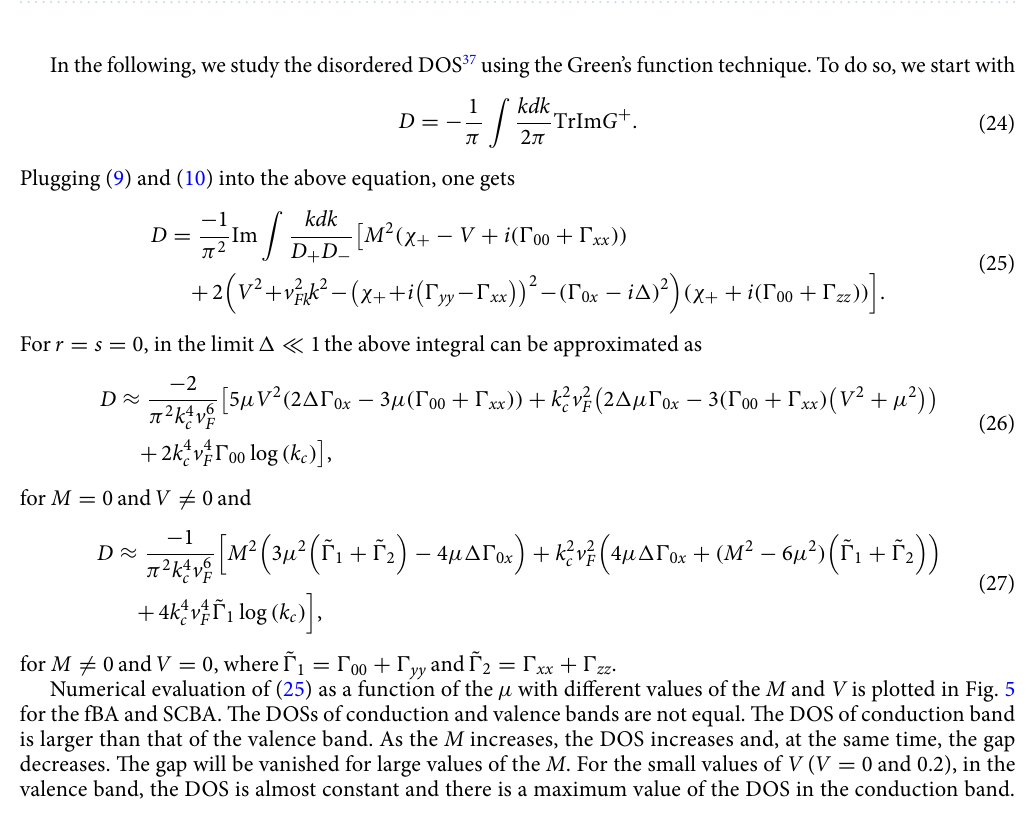
Figure 3. Real part of the self-energies as a function of the µ in the fBA and SCBA methods for ( a ) M = 0 and V = 0 , ( b ) M = 0.4 and V = 0 , ( c ) M = 0 and V = 0.4 , ( d ) M = 0.4 and V = 0.4 , ( e ) M > V with M = 0.4 and V = 0.2 , and ( f ) M < V with M = 0.2 and V = 0.4 . Here (cid:31) = 0.2 , γ b = 0.2 , s = 1 , and r = 1